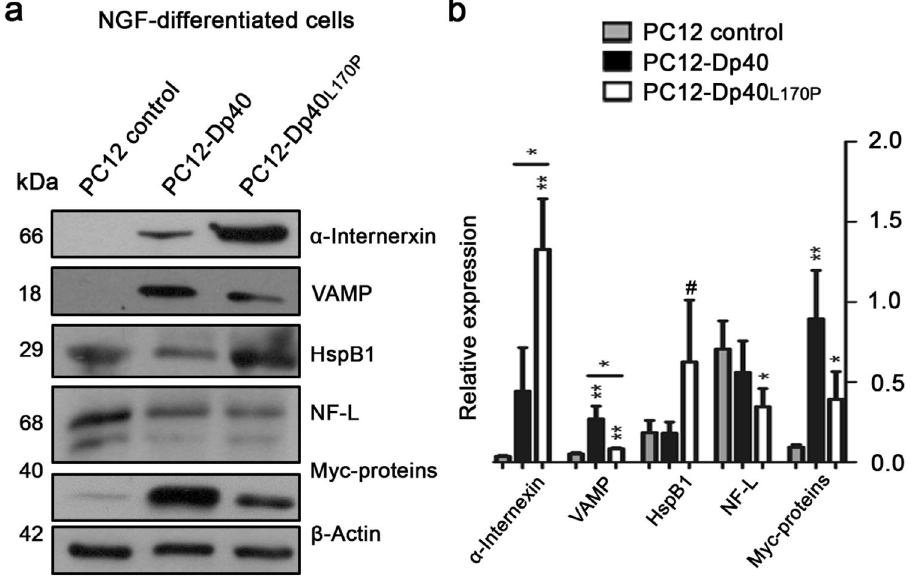
Figure 4. Differential expression of α-internexin, VAMP, HspB1, NF-L, Myc-Dp40 and Myc-Dp40 L170P in the NGF-differentiated PC12-Dp40 and PC12-Dp40 L170P cells. Protein extracts were obtained from the NGF- differentiated PC12 control, PC12-Dp40 and PC12-Dp40 L170P cells and analyzed by WB. ( a ) Expression of α-internexin, VAMP, HspB1, NF-L, Myc-Dp40 and Myc-Dp40 L170P . ( b ) Relative expression of α-internexin, VAMP, HspB1, NF-L, Myc-Dp40 and Myc-Dp40 L170P was determined as indicated in the materials and methods. The graph presents the mean ± SD from three independent experiments. ** P ˂ 0.002 and * P ˂ 0.021 for α-internexin comparing the PC12-Dp40 L170P with PC12 control and PC12-Dp40 cells, respectively. ** P ˂ 0.008 and ** P ˂ 0.007 for VAMP comparing the PC12 control with PC12-Dp40 and PC12-Dp40 respectively, and * P ˂ 0.015 comparing PC12-Dp40 and PC12-Dp40 L170P . * P ˂ 0.040 for NF-L comparing the PC12 control and PC12-Dp40 L170P cells. * P ˂ 0.010 and * P ˂ 0.040 for Myc-Dp40 and Myc-Dp40 L170P comparing the PC12-Dp40 and PC12-Dp40 L170P with PC12 control cells. No statistical difference was observed for HspB1 ( # P > 0.1). β-Actin was used as a loading control. Molecular weight of each protein is indicated in kDa. The blots of each protein are available in Supplementary Fig.